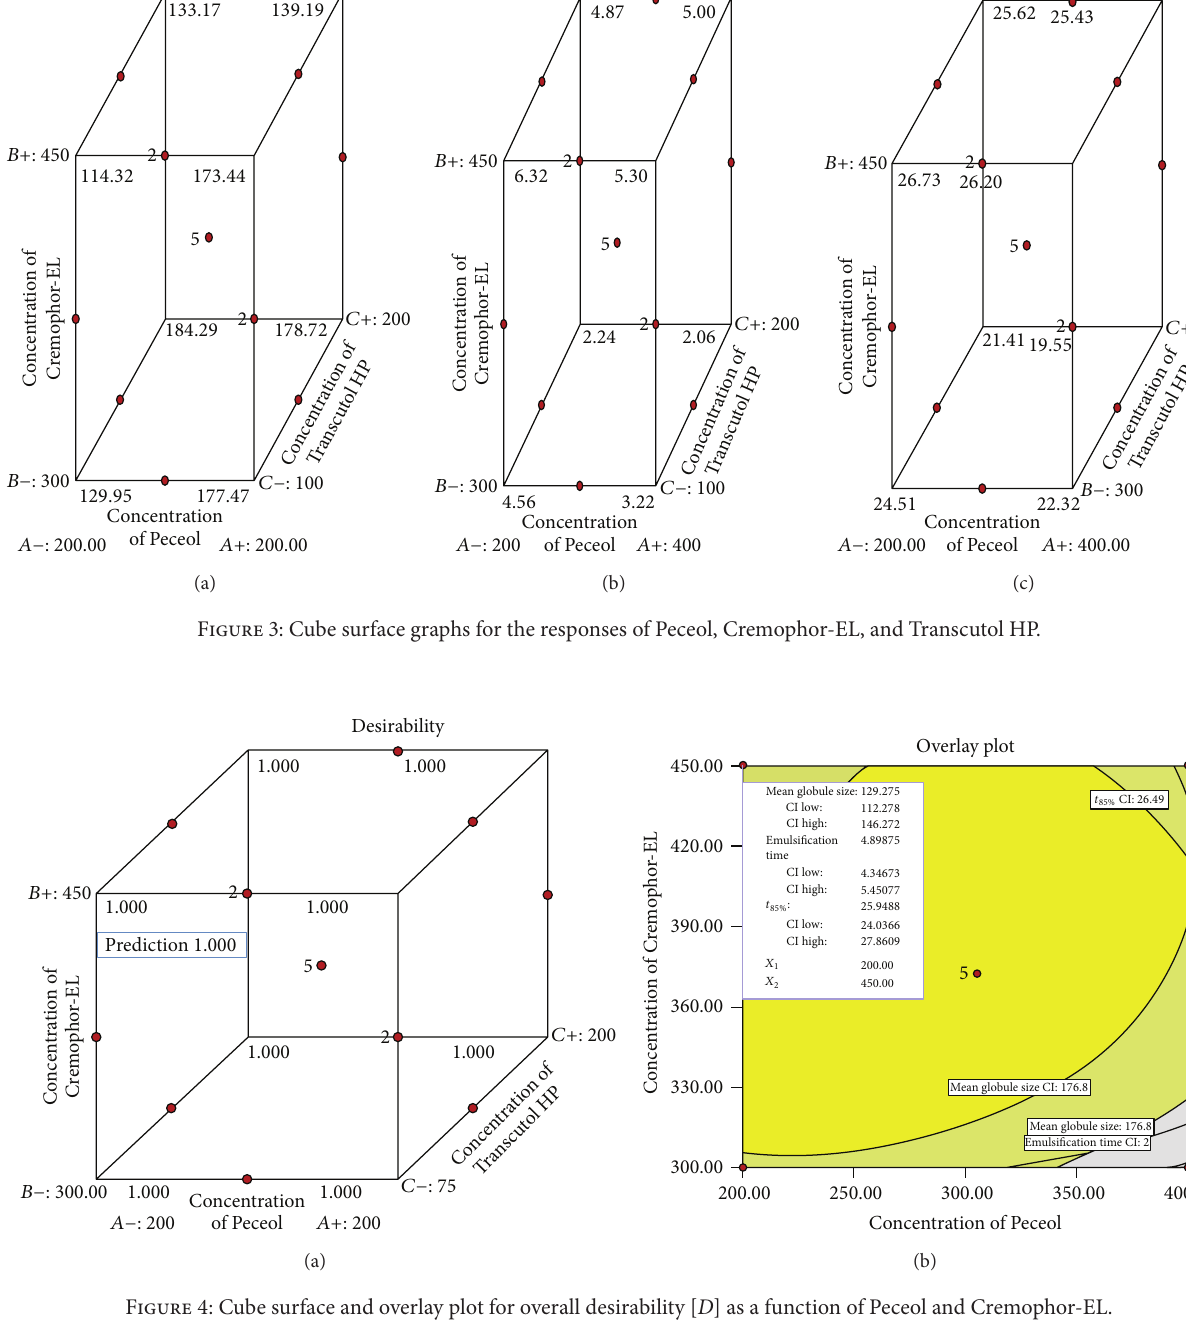
and overlay plots in a variable range of oil and surfac- tant. Optimized levels of oil, surfactant, and cosurfactant were found to be 200 mg, 450 mg, and 150 mg,